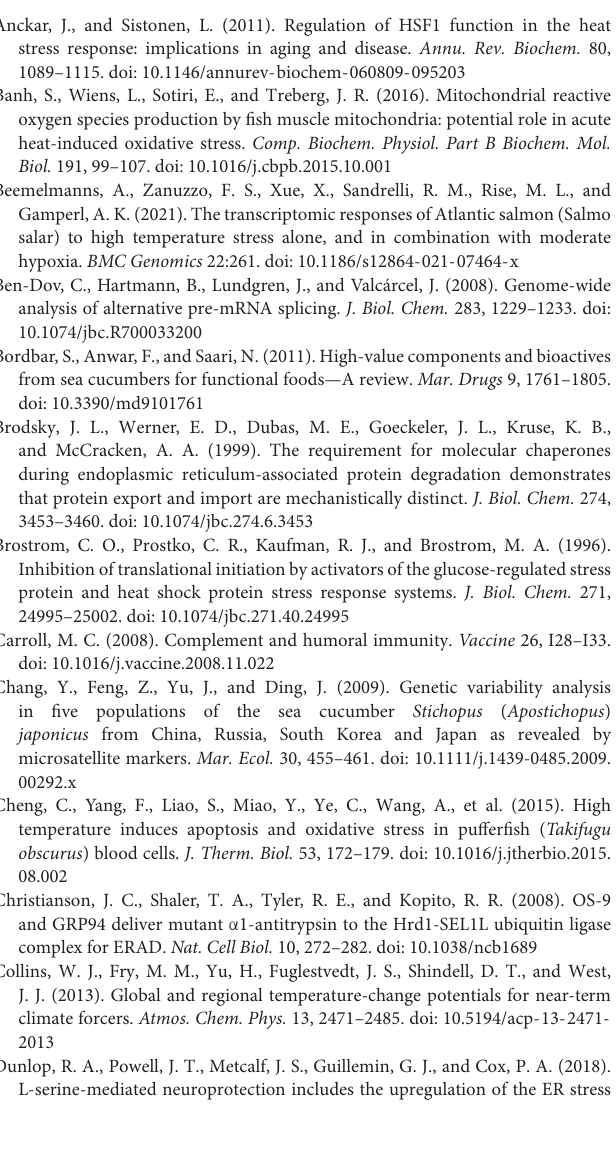
Supplementary Table 3 | Detailed information of differential alternative splicing (DAS) events.